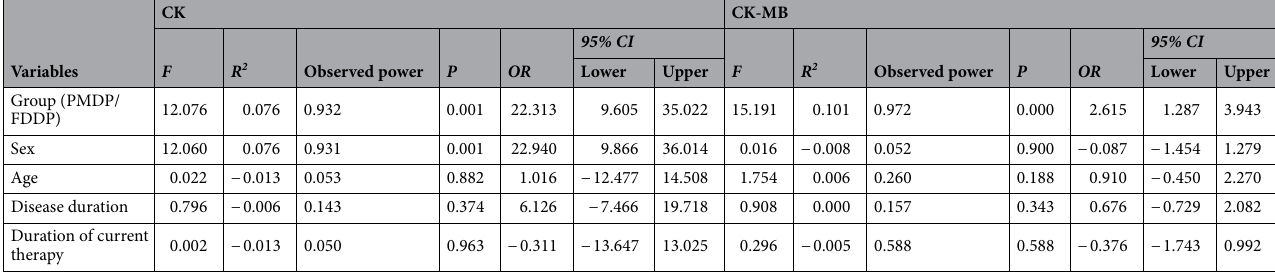
Table 3. Univariate covariance analysis of factors related to elevated CK and CK-MB. The baseline level of CK or CK-MB was taken as a covariate.